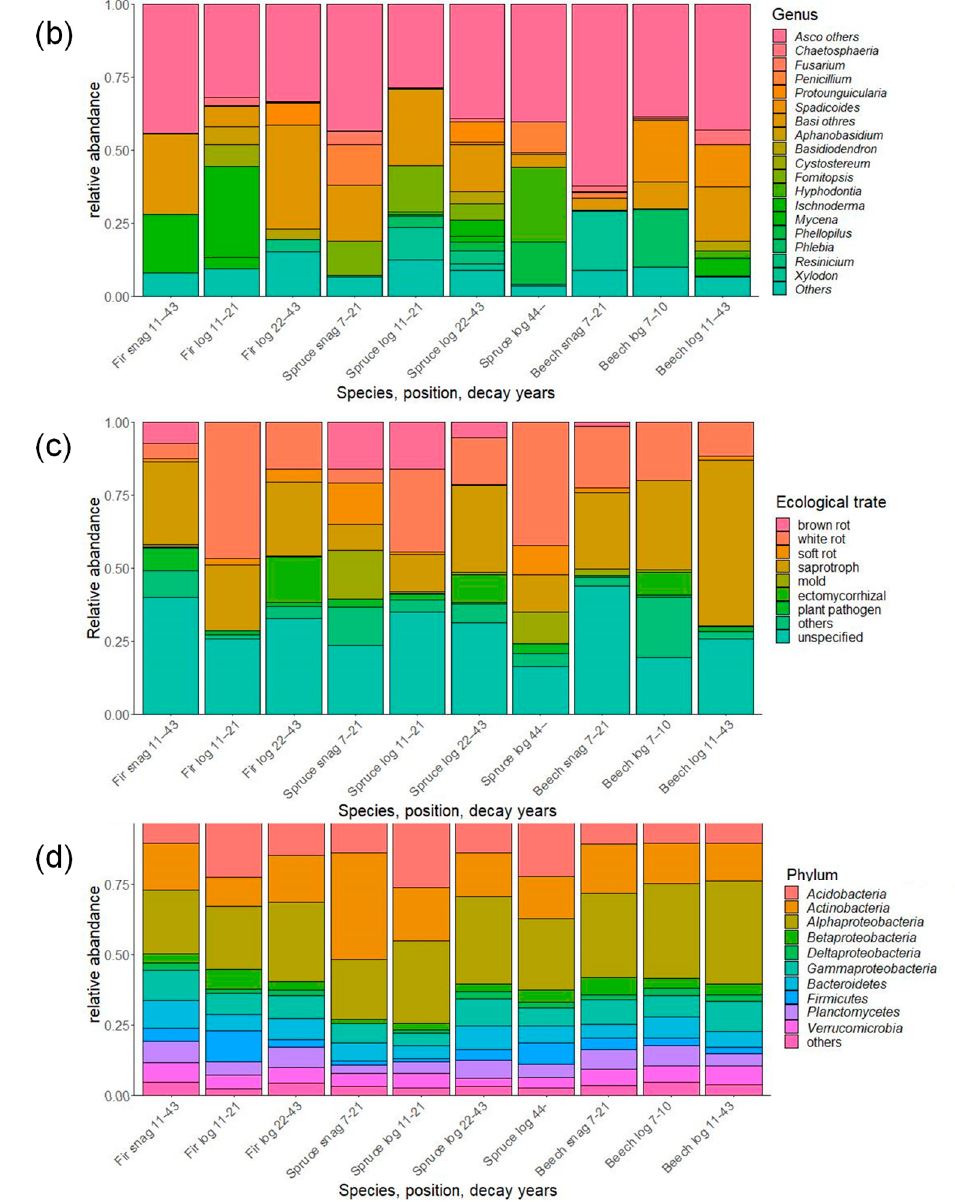
Figure 3. Composition of fungal and bacterial communities associated with dead wood in the Zofin Forest on the level of ( a ) fungal phylum, ( b ) genus, ( c ) ecological trait, and ( d ) bacterial phylum/class.